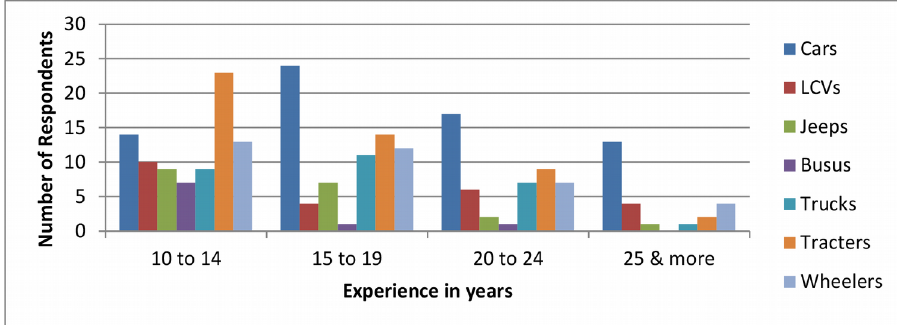
Figure 3. Number of respondents according to their experience and vehicle manufacturing